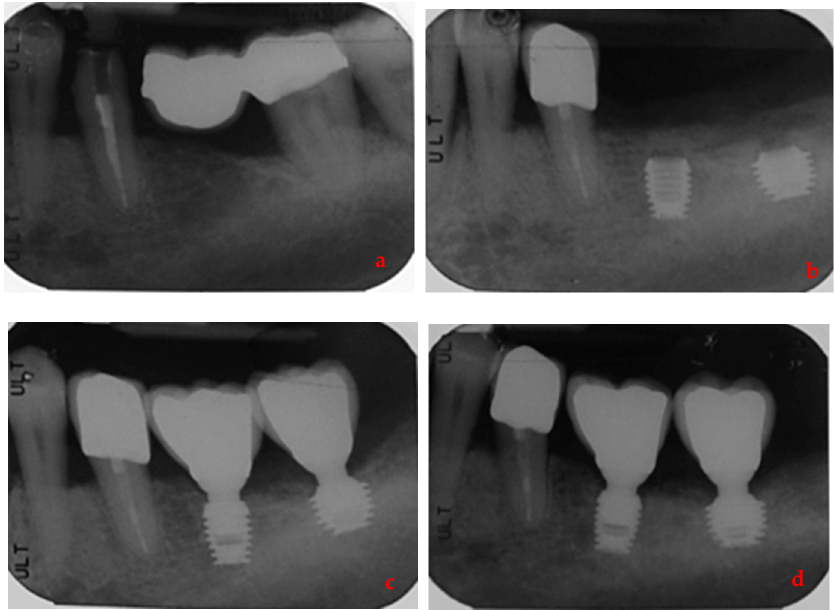
Figure 1. Single implants placed in 3.6 and 3.7 sites (4.5 × 6 mm and 6 × 5 mm) of a male patient with history of periodontal disease: ( a ) pre-operative radiograph before implants placement; ( b ) radiograph obtained at implants placement; ( c ) radiograph obtained at time of loading; ( d ) radiograph obtained at 3-year follow-up.